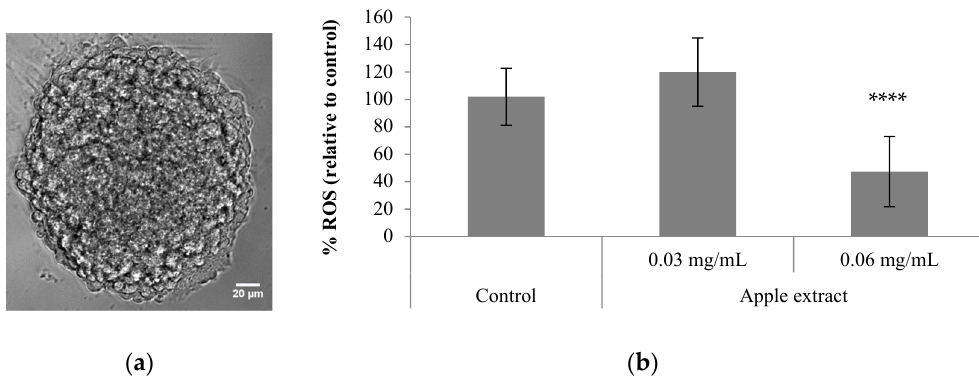
Figure 2. In vitro neuroprotective effect of Bravo de Esmolfe apple extract—a 3D cell model approach: ( a ) phase contrast image of human differentiated neurospheroids derived from NT2 cells; ( b ) effect of apple extract on ROS levels present in neurospheroids incubated with t-BHP (256 µM). Results shown are means of at least 5 replicates ± SD; p < 0.05 was considered as statistically significant (**** p < 0.0001 is relative to the control).